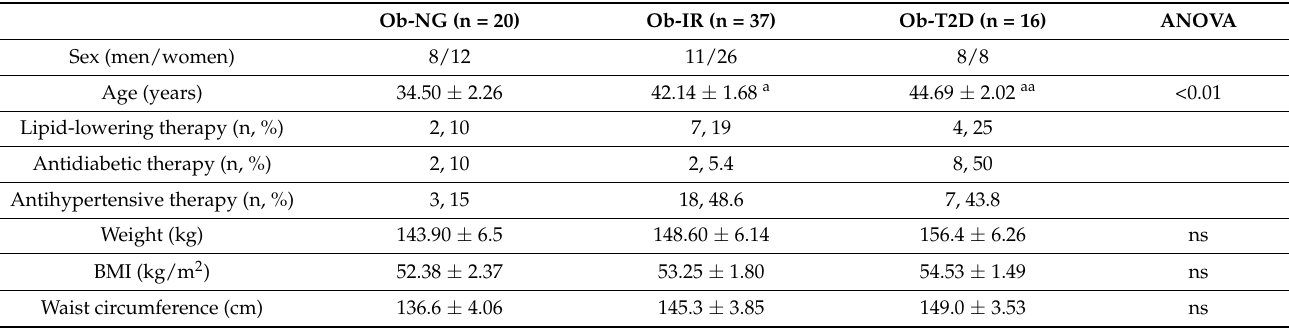
Table 1. Anthropometric and biochemical characteristics of